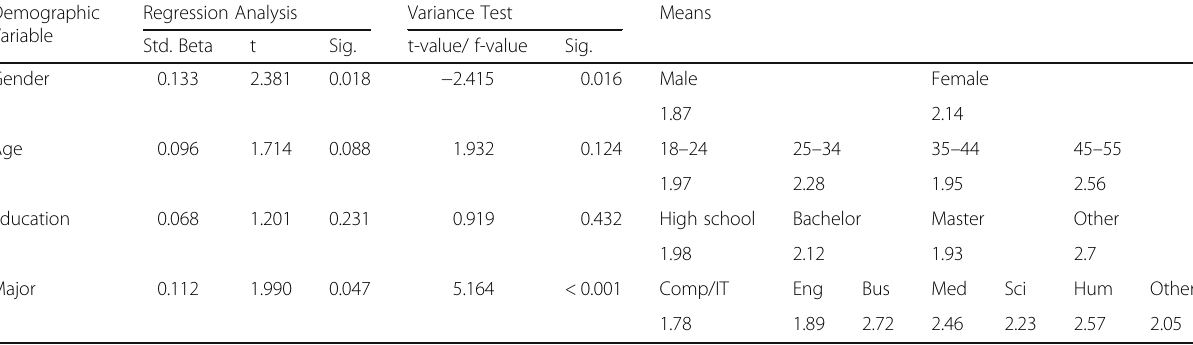
Table 10 Demographic factors impact on user susceptibility to SE Demographic Regression Variable